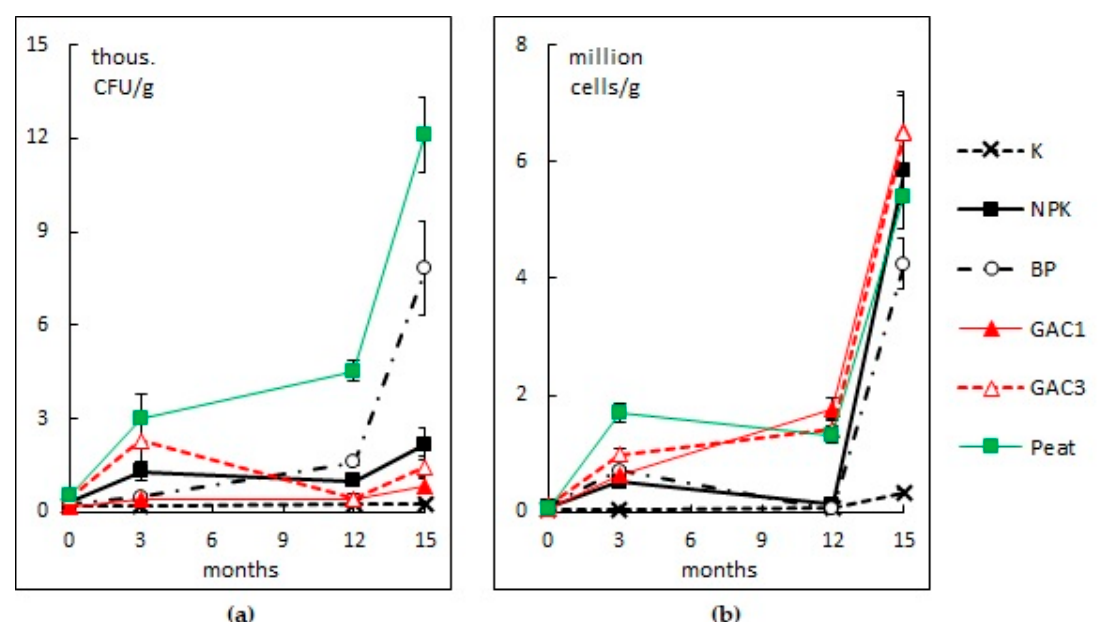
Figure 6. The dynamic of the number of hydrocarbon-oxidizing microfungi (a) and bacteria (b) in soil with different methods of bioremediation.